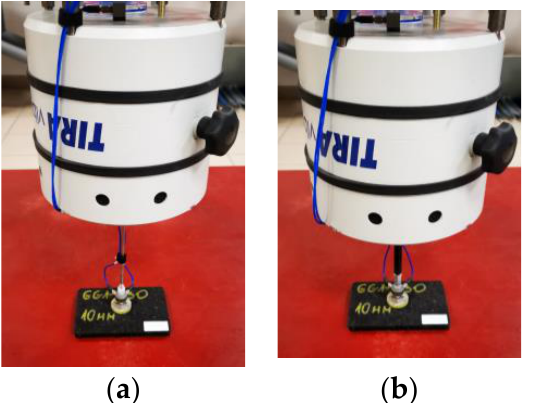
Figure 2. View of the test stand with the stinger mounted: ( a ) made of stainless steel; ( b ) made of polyamide.